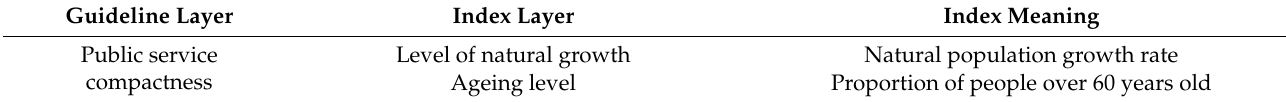
Table 1. Urban shrinkage evaluation index